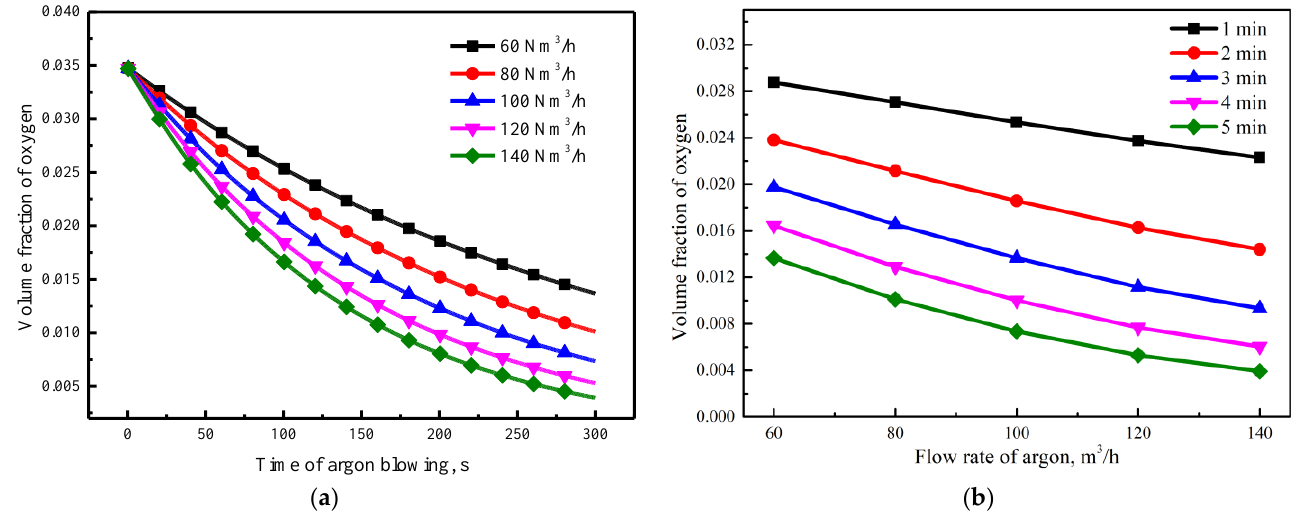
Figure 11. Variation of oxygen volume fraction with time for different argon flow rate ( a ), and effect of argon flow rate on volume fraction of oxygen at different times ( b ) in an isolated casting chamber.